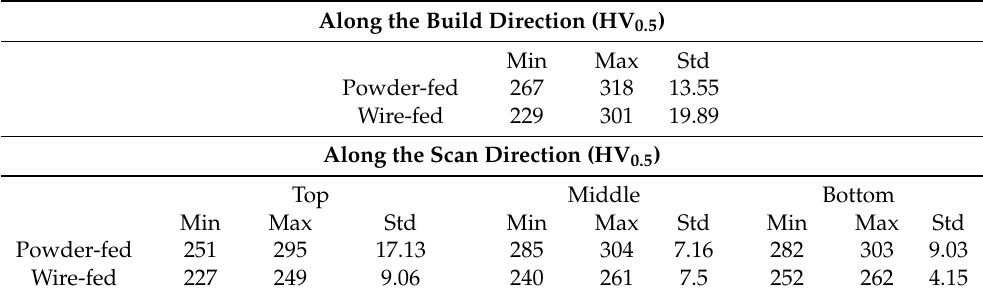
Table 5. Range of microhardness values observed at different locations for powder-fed and wire-fed L-DED specimens. Along the Build Direction (HV 0.5 ) Min Max Std Powder-fed 267 318 13.55 Wire-fed 229 301 19.89 Along the Scan Direction (HV 0.5 ) Top Middle Bottom Min Max Std Min Max Std Min Max Std Powder-fed 251 295 17.13 285 304 7.16 282 303 9.03 Wire-fed 227 249 9.06 240 261 7.5 252 262